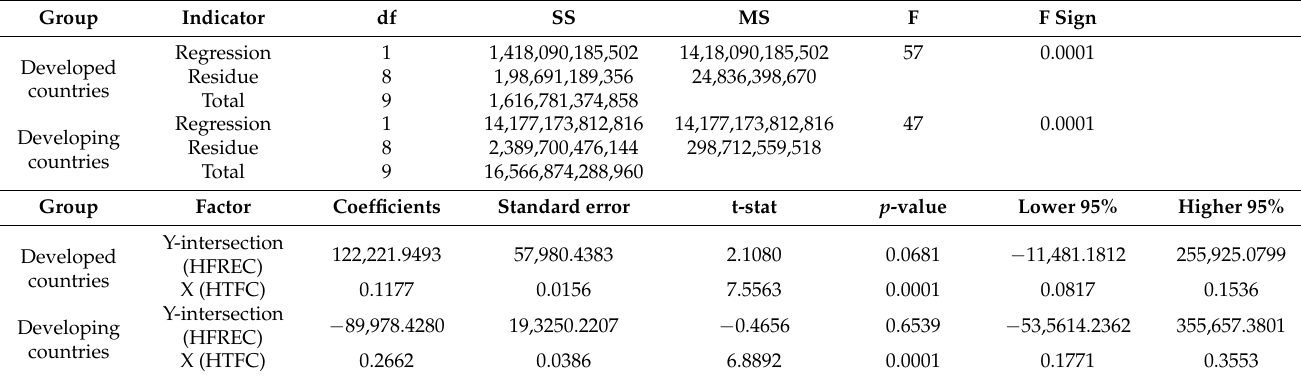
Table 4. Indicators of analysis of variance for total energy consumption and consumption of renewable energy by households. Group